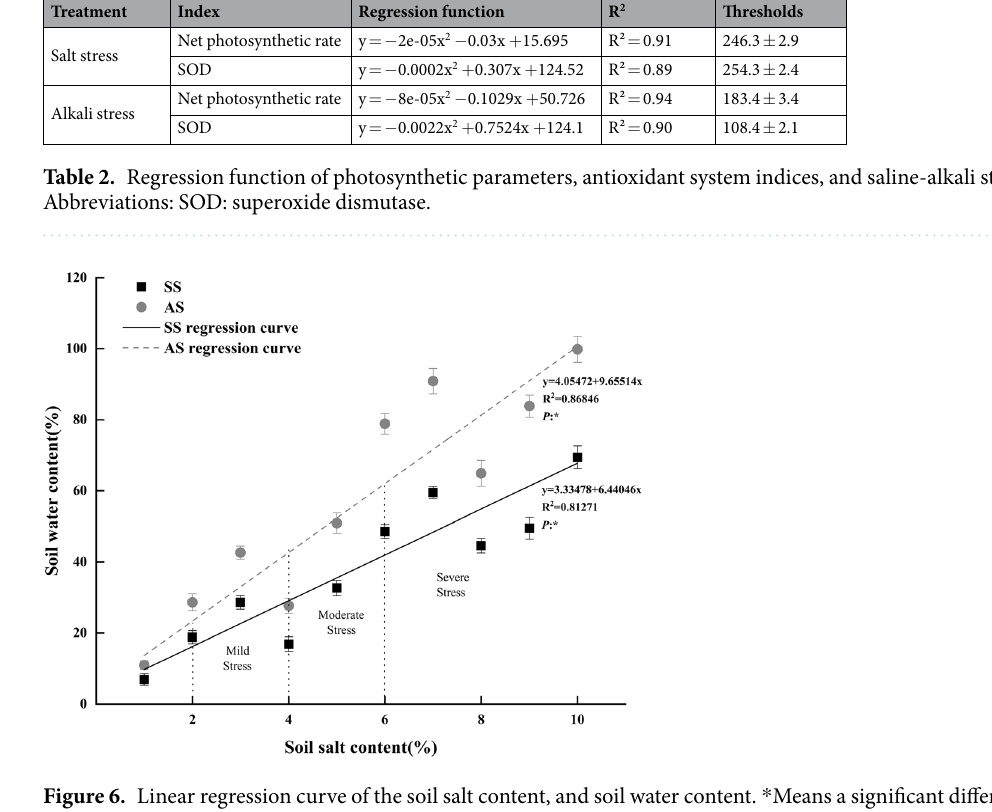
Linear regression of soli salt content and soil water content. Based on the analysis of P activity of Goji berry under salt and alkali stress, the salt and alkali tolerance threshold range of Goji berry was determined to be 246.3 ± 2.9 mM and 108.4 ± 2.1 mM, respectively (P < 0.05, Table 2). The relationship between the salt content and water content of the local soil is shown in Fig. 6, and it is calculated based on the threshold of salinity (NaCl) and alkalinity (NaHCO 3 ) of Goji berry. According to the Chinese criteria for the classification of soil salt-alkalization, a salt content of 2–4% indicates mild stress, 4–6% indicates moderate stress, and over 6% indicates severe stress 28 . As shown in Fig. 6, the minimum soil water content to cultivate Goji berry should be 16.22% and 23.37% in mild and moderate stress soils, respectively, and 29.10% and 42.68% in mild and moderate alkali stress soils, respectively.